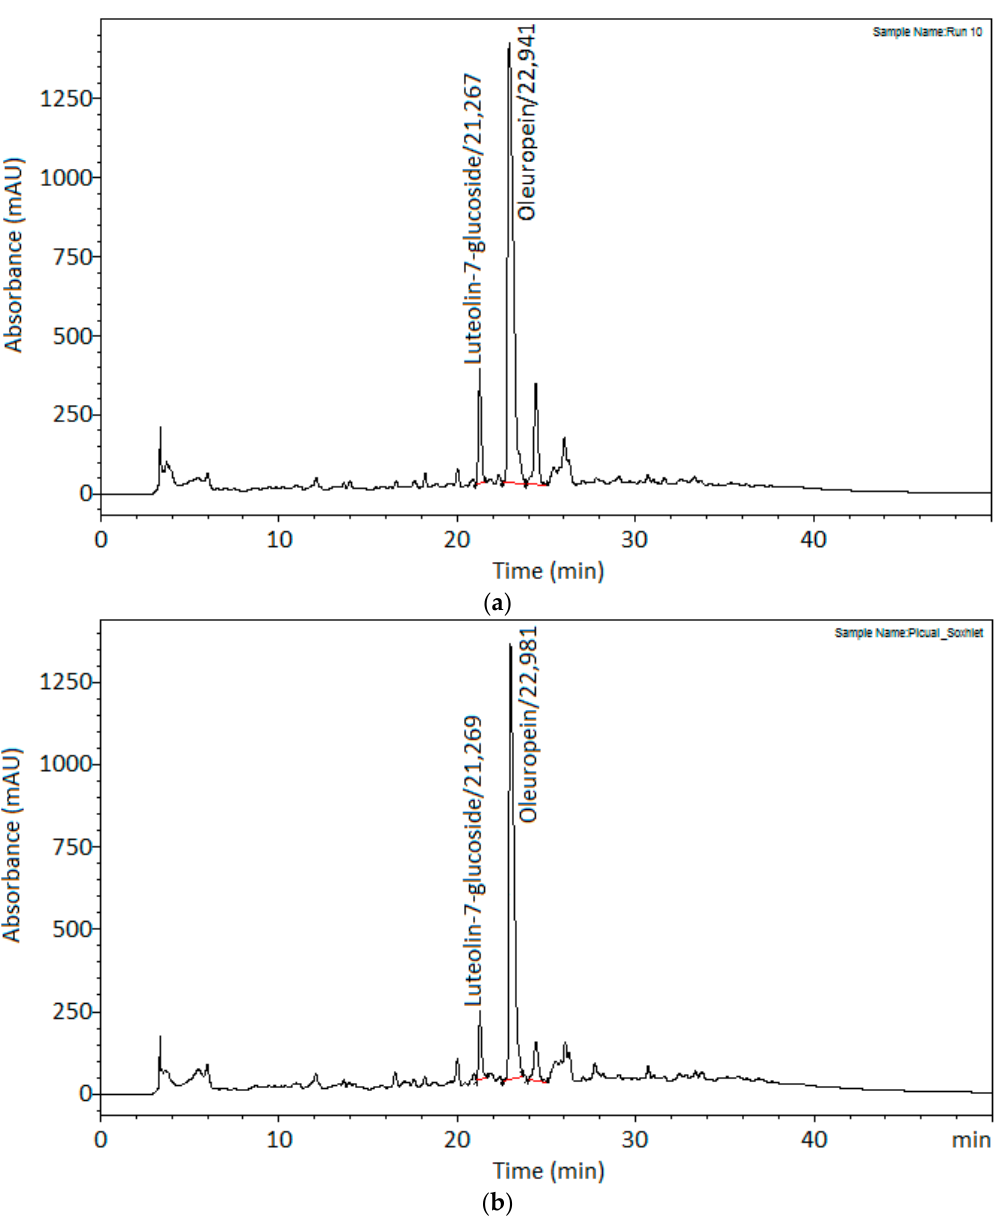
Figure 3. Representatives HPLC chromatograms recorded at 280 nm of olive leaves extracts recovered by UAE under the following conditions: 44.1 °C of Δ T and amplitude 45% ( a ) and Soxhlet extraction for 4 h; ( b ) the peaks of oleuropein and luteolin-7-glucoside appear marked in the chromatograms.